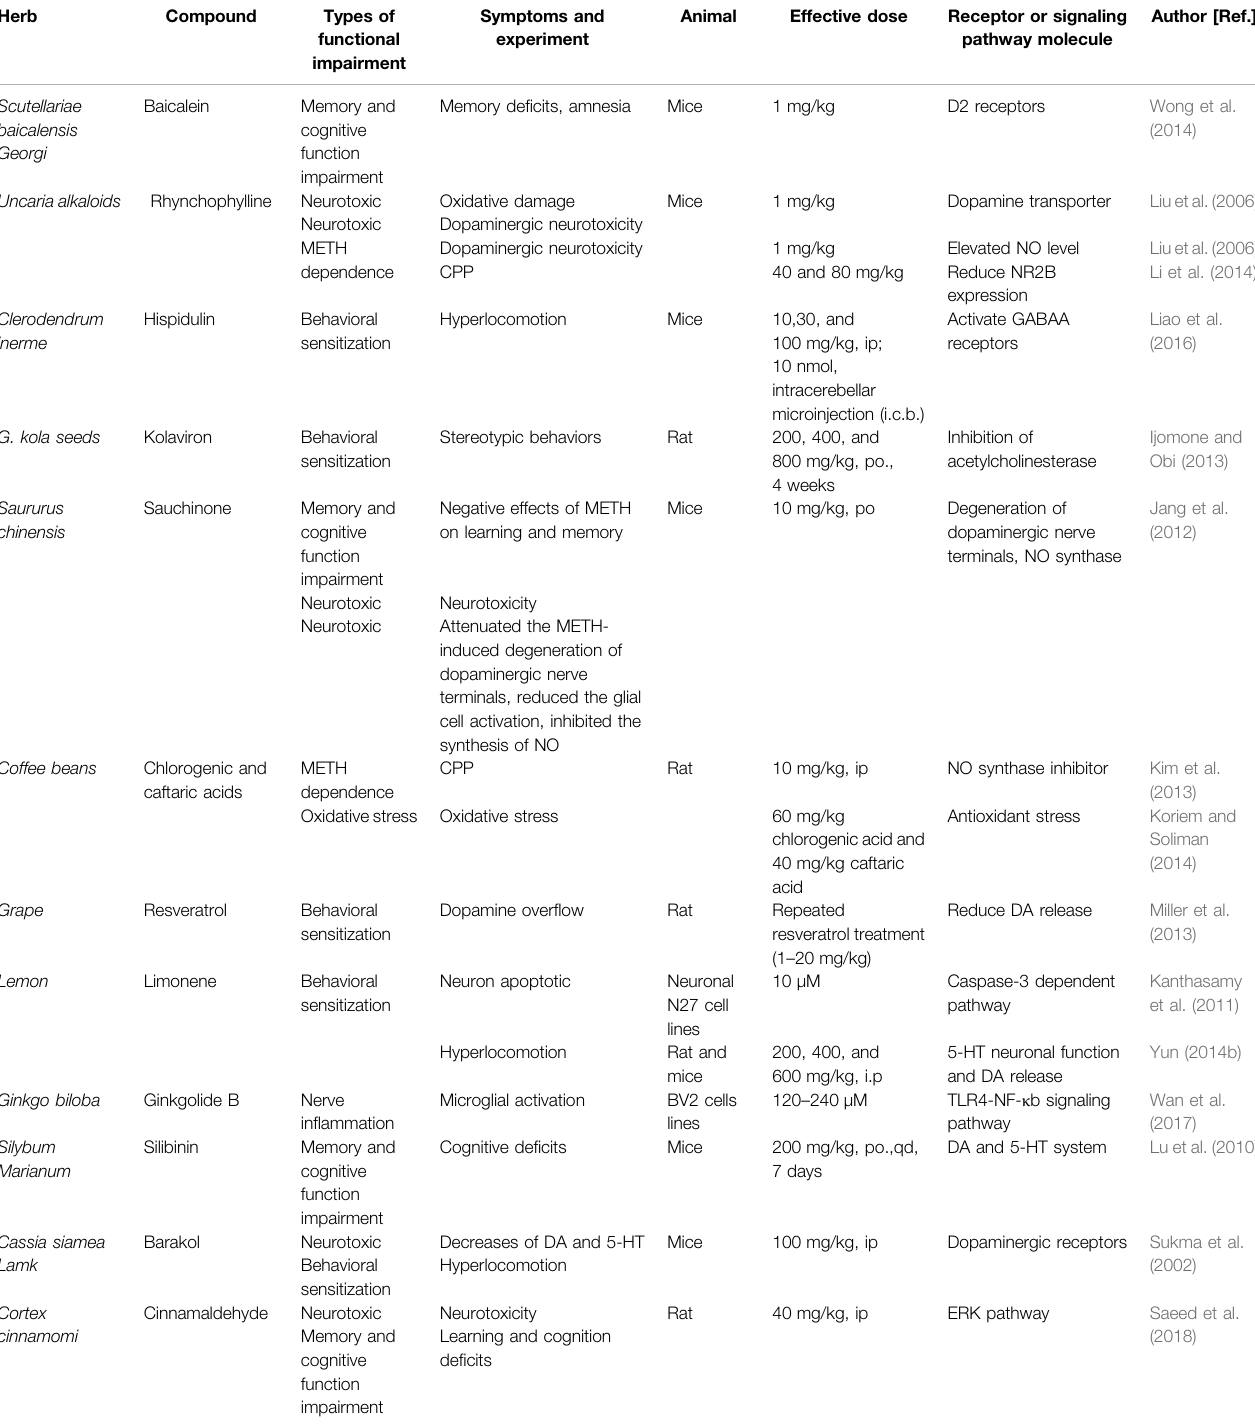
TABLE 4 | Summarized effects of other TCM therapy on METH abuse and other psychiatric